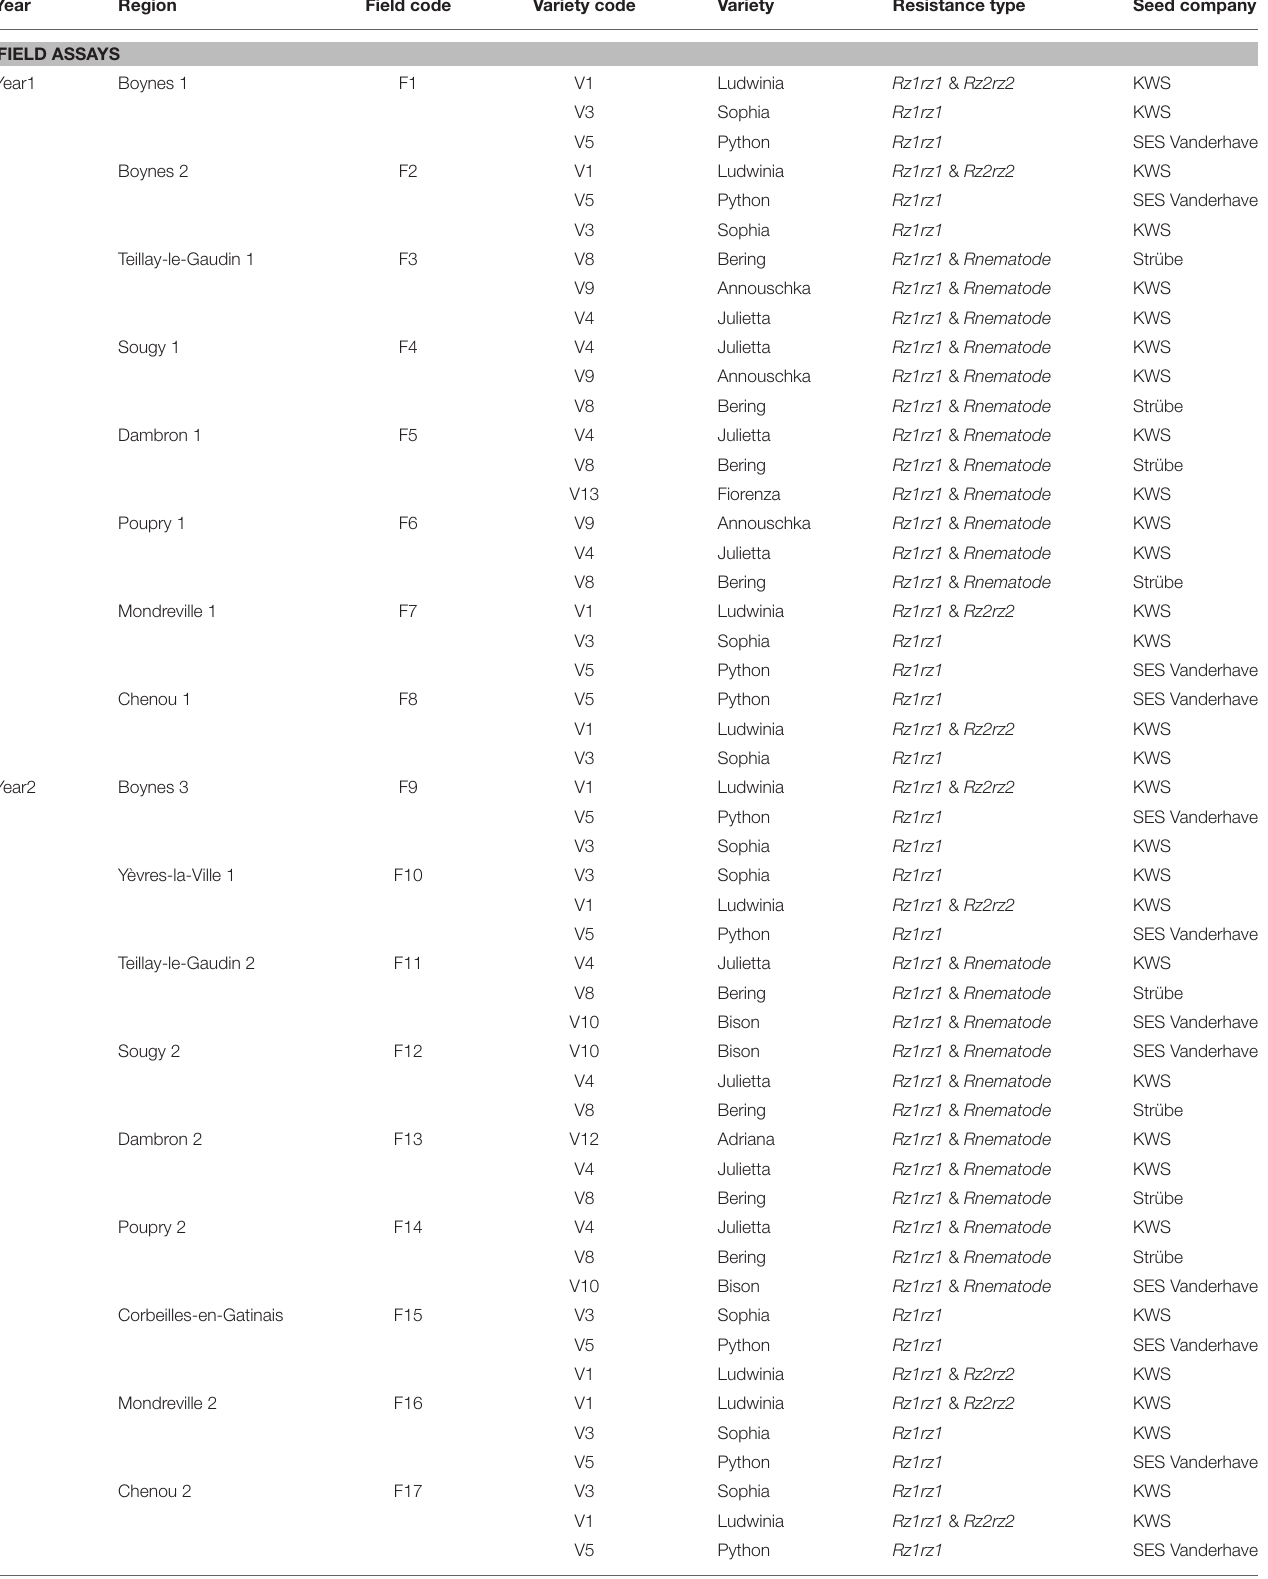
TABLE 1 | Locations where field assays were conducted in France and plant